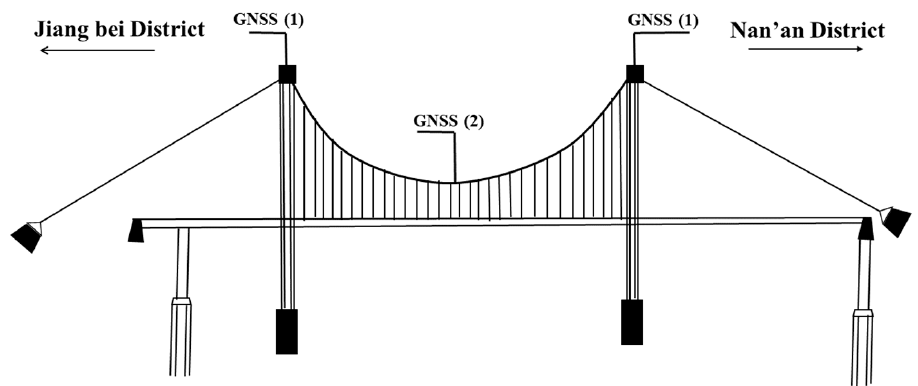
Remote Sens. 2022 , 14 , x FOR PEER REVIEW Figure 10. The low-cost GNSS sensor layout of Guojiatuo Suspension Bridge. Figure 10. The low-cost GNSS sensor layout of Guojiatuo Suspension Bridge.